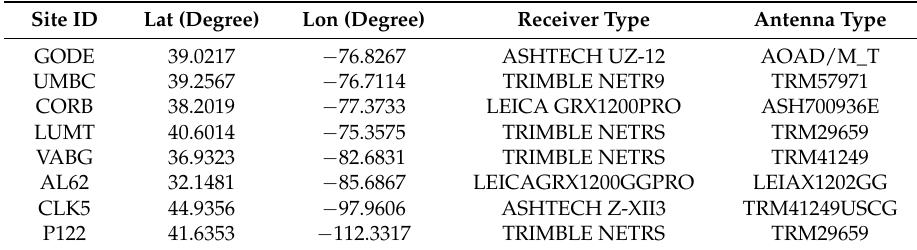
Figure 2. Selected GPS stations. Table 2. Station information.